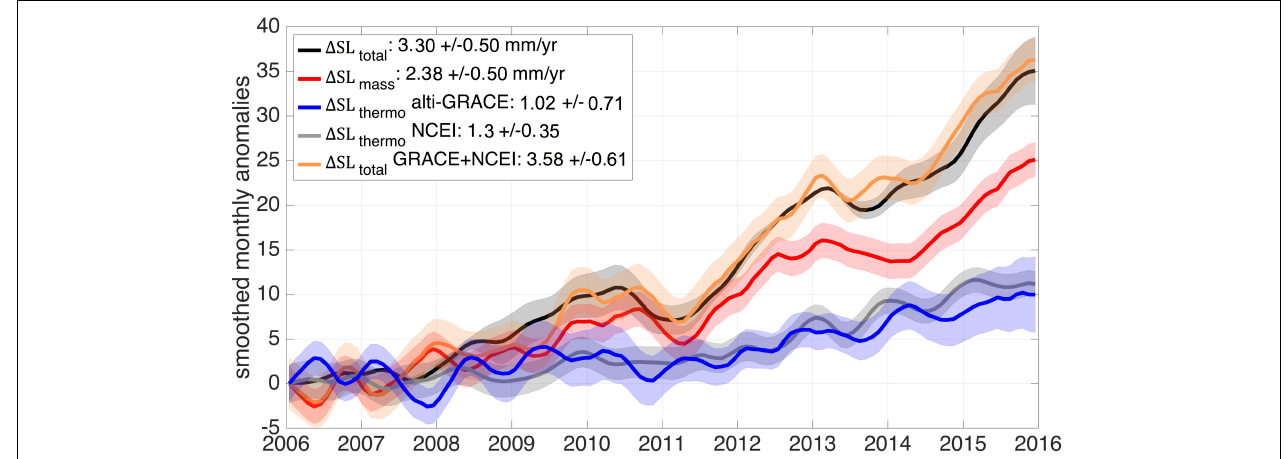
FIGURE 8 | Global mean anomalies of global mean sea level in mm (monthly anomalies, 5-months running means) derived from six altimetry data sets presented in section “Sea Level” ( (cid:49) SL total , black), ocean mass change from four GRACE products ( (cid:49) SL mass , red), thermosteric sea level change as the residual of (cid:49) SL thermo = (cid:49) SL total – (cid:49) SL mass (blue), (cid:49) SL thermo from NOAA NCEI (gray) based on interpolated seasonal anomalies, and (cid:49) SL total as the sum of (cid:49) SL thermo from NCEI and (cid:49) SL mass (orange). The shadings indicate the measurement uncertainty (5–95% CL); the 5–95% CL trend uncertainties in the legend are provided by the data centers and are detailed in the main